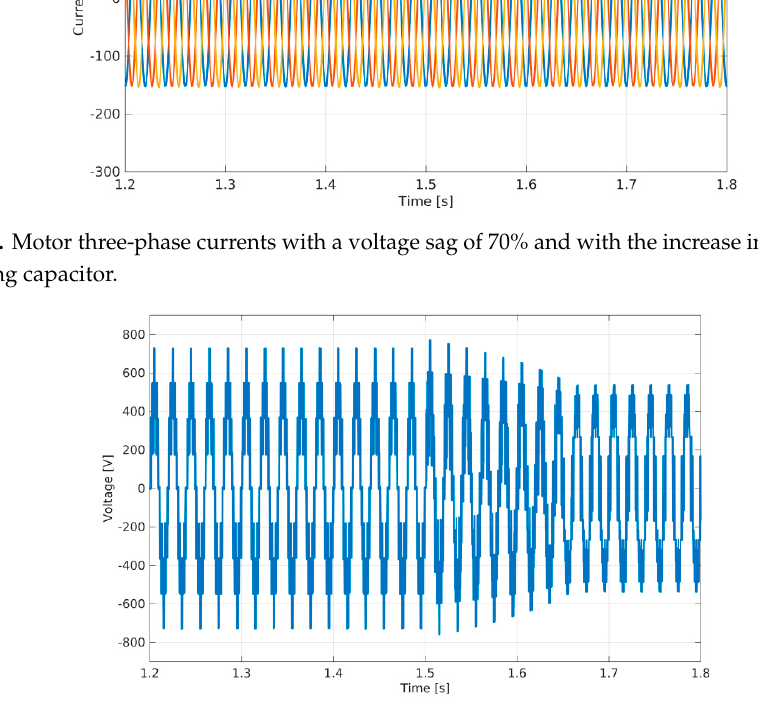
Figure 16. Phase voltage applied to winding 1 with a voltage sag of 70% and with the increase in the voltage of the floating voltage of the floating capacitor.